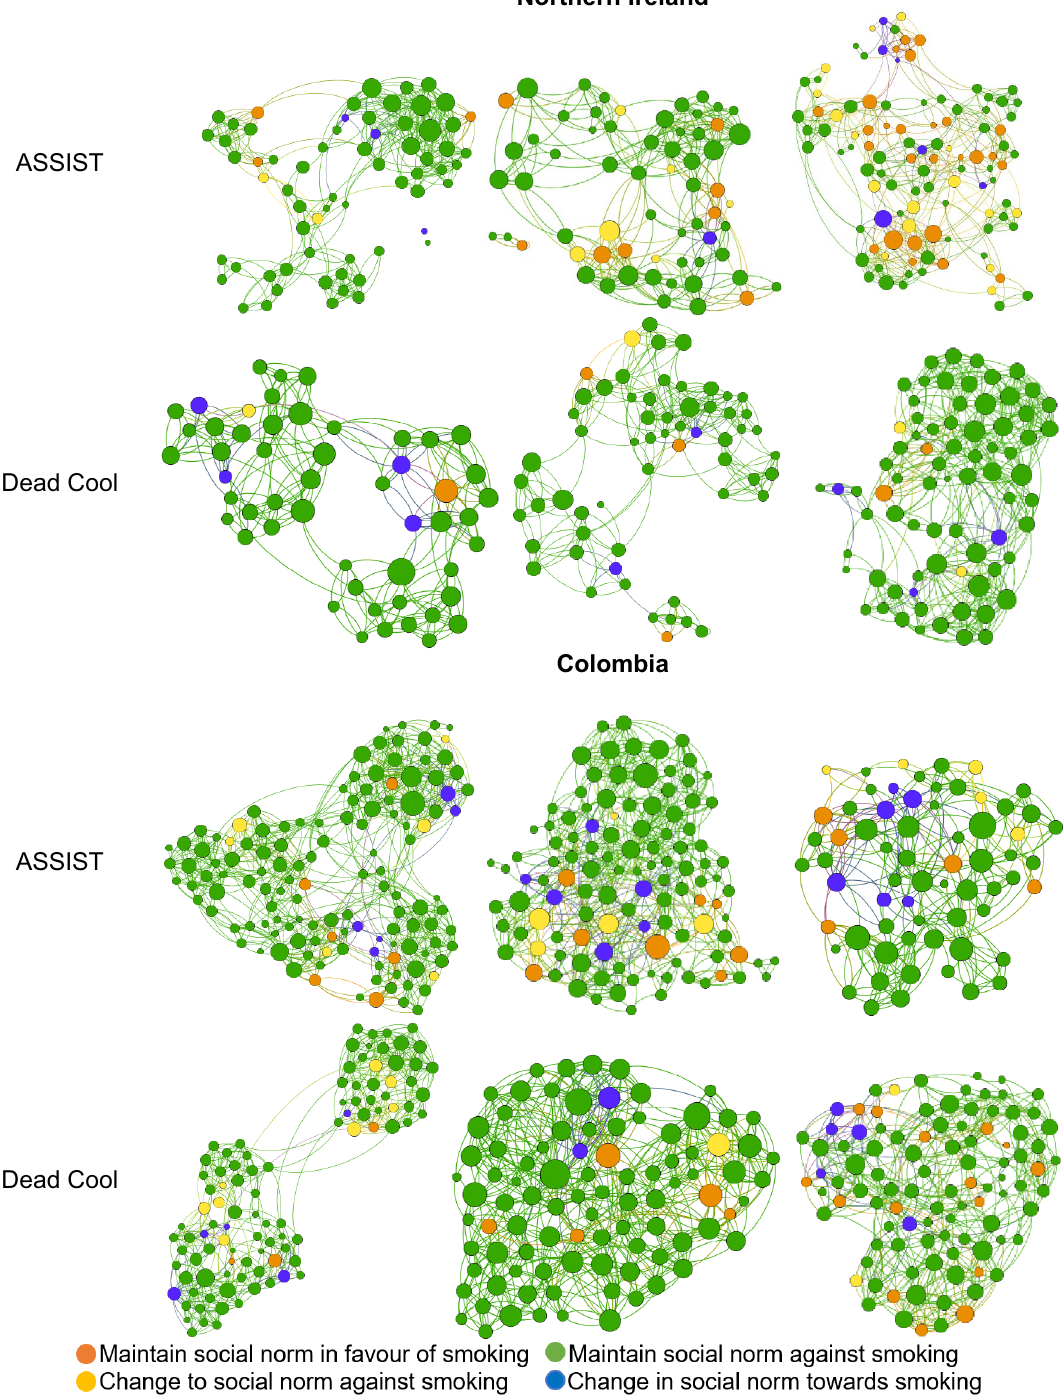
Figure 2. Friendship networks, sorted by setting and intervention. Nodes: students. Edges: friendship nominations at baseline. For nodes: color is the corresponding change in social norm, size is the